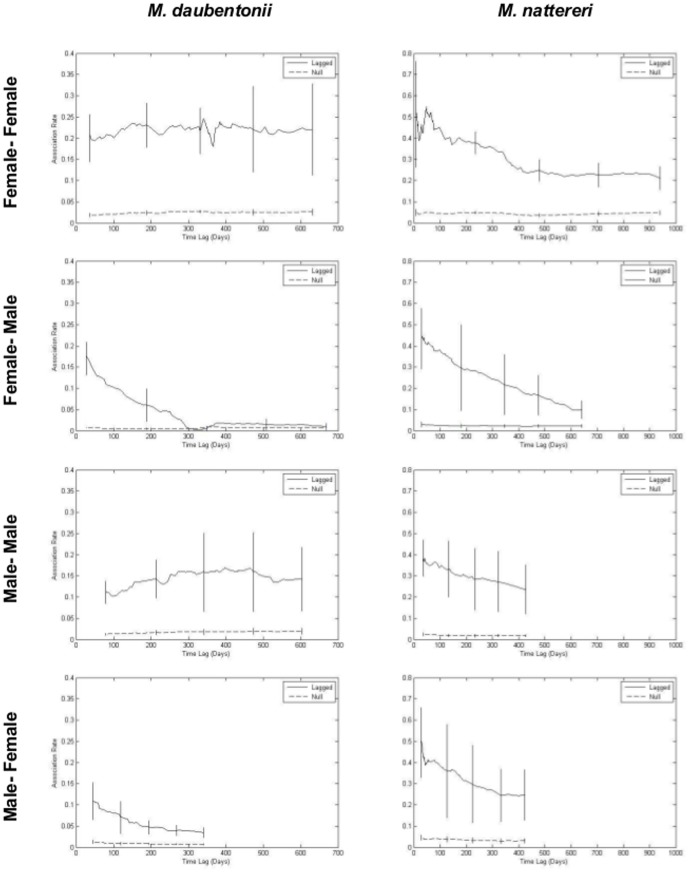
Lagged association rates within and between sexes of M. daubentonii (left) and M. nattereri (right).Standard error is calculated by jackknifing over a 30-day period.